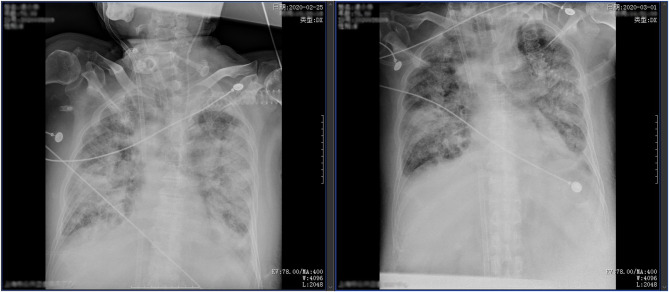
After glucocorticoid therapy, chest radiographs showed no significant reduction in pulmonary exudation, suggesting no improvement in lung inflammation.